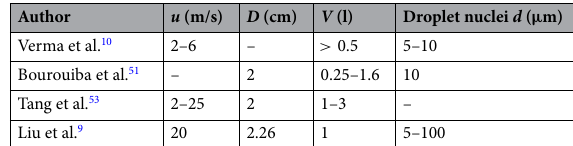
Figure 1. Non-dimensional vorticity magnitude | (cid:31) | iso-surfaces, normalised with U 3 C3DN2 at t = 4 × 10 s (top) C3DN4 t = 8 × 10 to twice the injection period T for each one of the cases simulated.